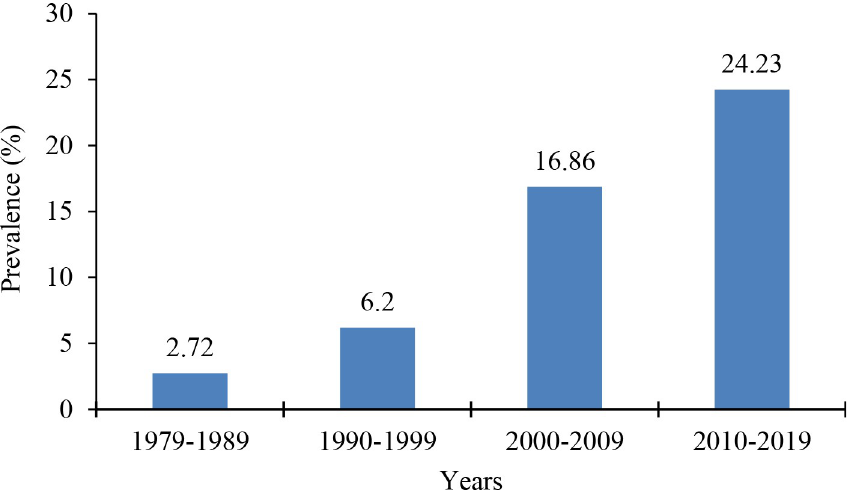
Fig 3. Seroprevalence of brucellosis in food-producing animals in Mosul, Iraq over a period of forty years (1979– 2019).